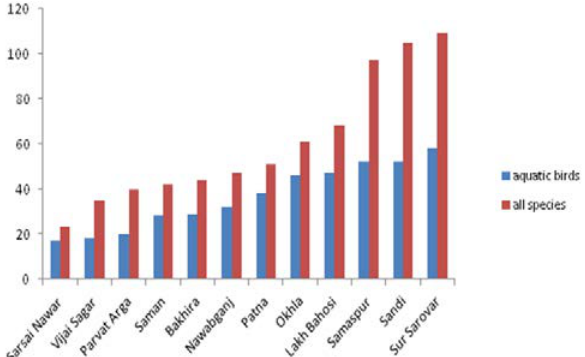
Fig. 9. Vertical bars showing species richness in different wetlands